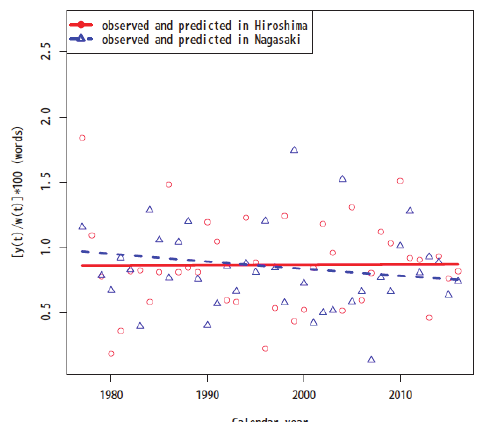
Fig. 4. Estimates and 95% simultaneous CI of regression coefficient in "hibakusha"